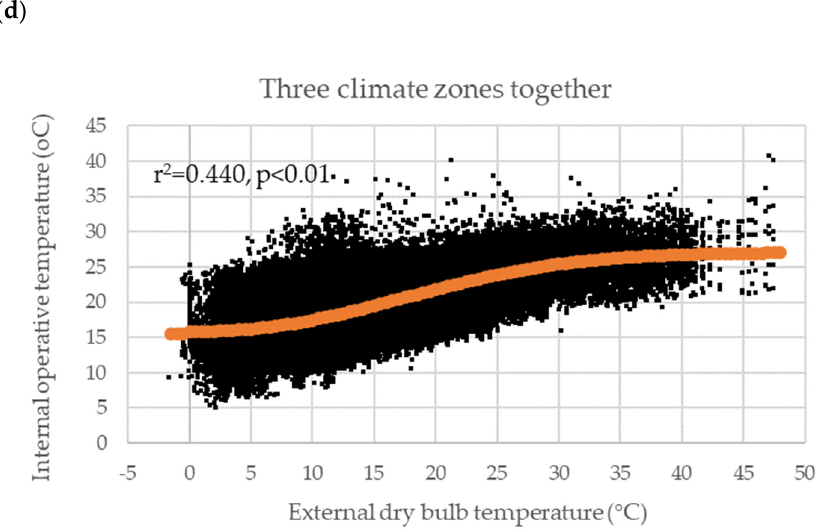
Figure 2. External dry bulb temperature and corresponding internal operative living room temperature of homes in climate zones ( a ) Iron Triangle— Bsk (Zone 4); ( b ) Adelaide— Csa (Zone 5); ( c ) Fleurieu— Csb (Zone 6); ( d ) the three climate zones together, showing an exponential line of best fit; n = 10,813. Table 3. Best fit constants for Equation